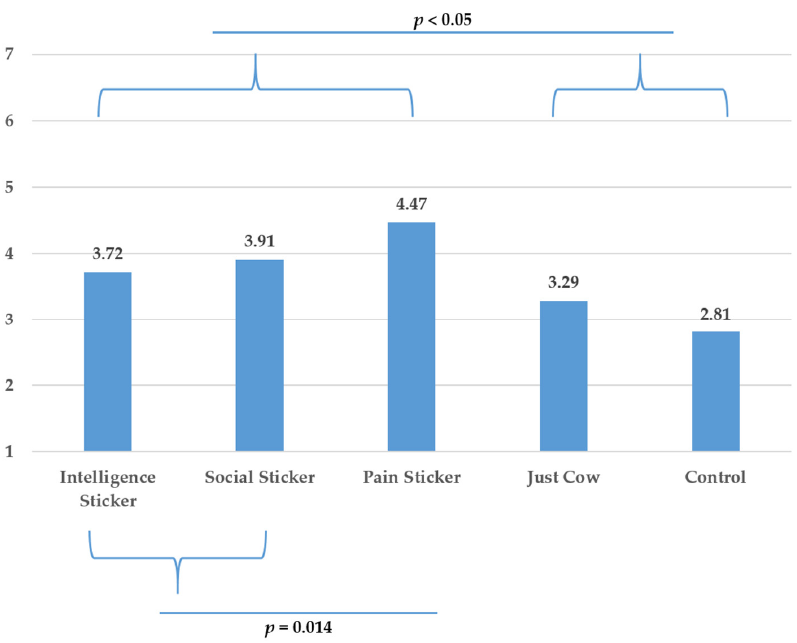
Figure 5. Intentions to reduce meat consumption due to packaging: Means for the different conditions and results contrast analyses (Study 1).